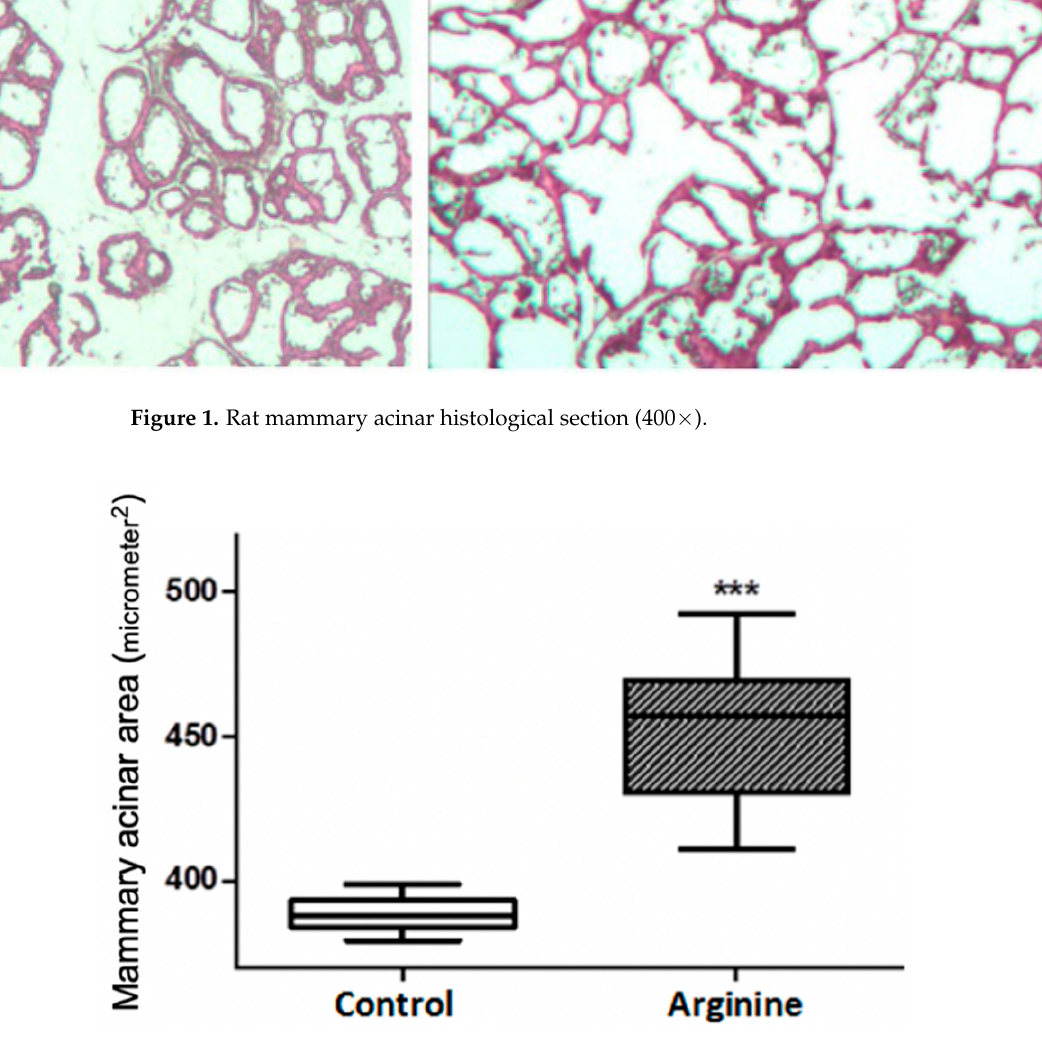
Figure 2. Comparison of mammary acinar area (um 2 ) *** Represents p < 0.001.